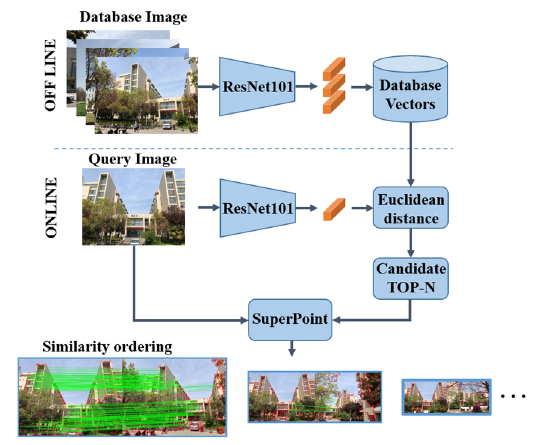
Figure 5. Solution A. Extracting global feature based